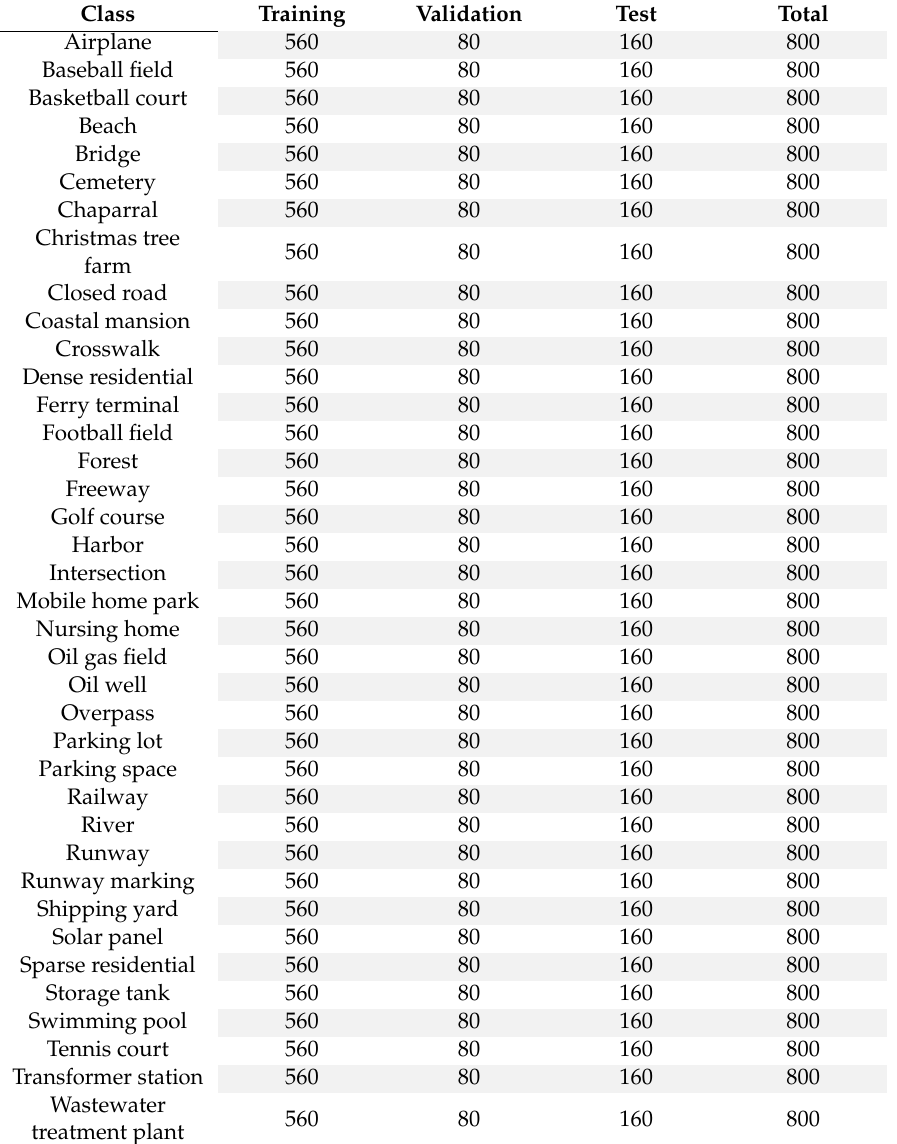
Table 3. Number of samples for training, validation, and test used for the PatternNet dataset. Class Training Validation Test